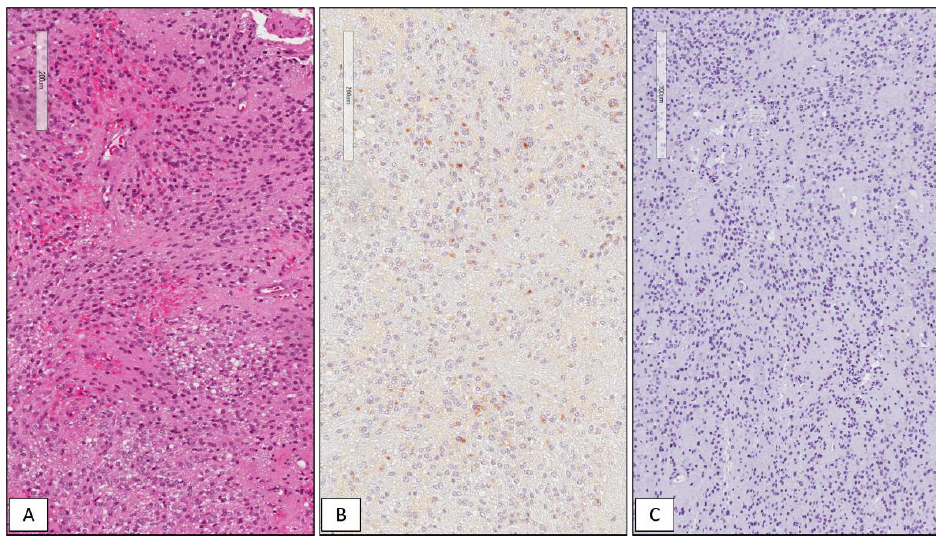
Figure 3. WHO grade II classic ependymoma. Histopathological examination showing a moderately cellular lesion, composed of small cells with rounded nuclei arranged in perivascular pseudorosettes with no evidence of anaplastic features ( A ); perinuclear “dot-like” staining for EMA highly suggestive for a diagnosis of ependymoma ( B ); absence of immunohistochemical expression of SRSF1 in WHO grade II classic ependymoma ( C ) (hematoxylin and eosin ( A ) and immunoperoxidase ( B , C ) staining; original magnifications 100×, 100× and 100×).